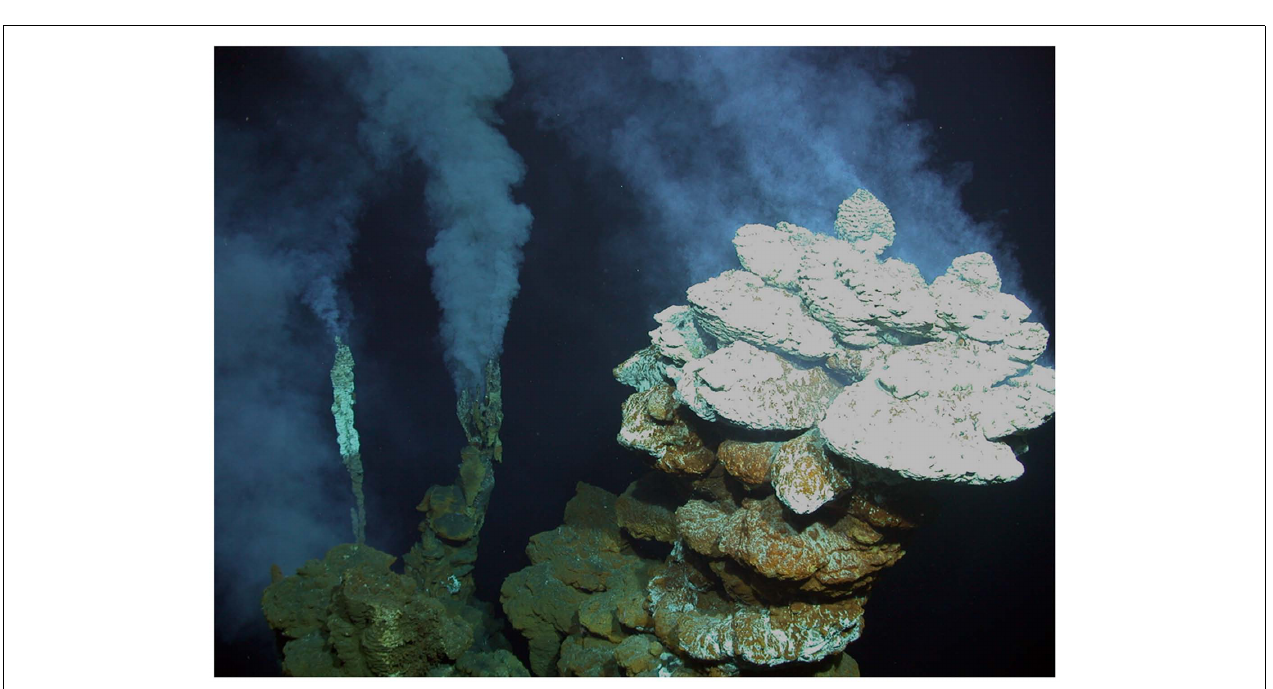
FIGURE 1 | Photograph of deep-sea hydrothermal vent mineral deposits from the Eastern Lau Spreading Center. A series of horizontal flanges are shown in the foreground while two vertical chimneys can be seen in the background. Photo was taken from ROV Jason II (courtesy ofWoods Hole Oceanographic